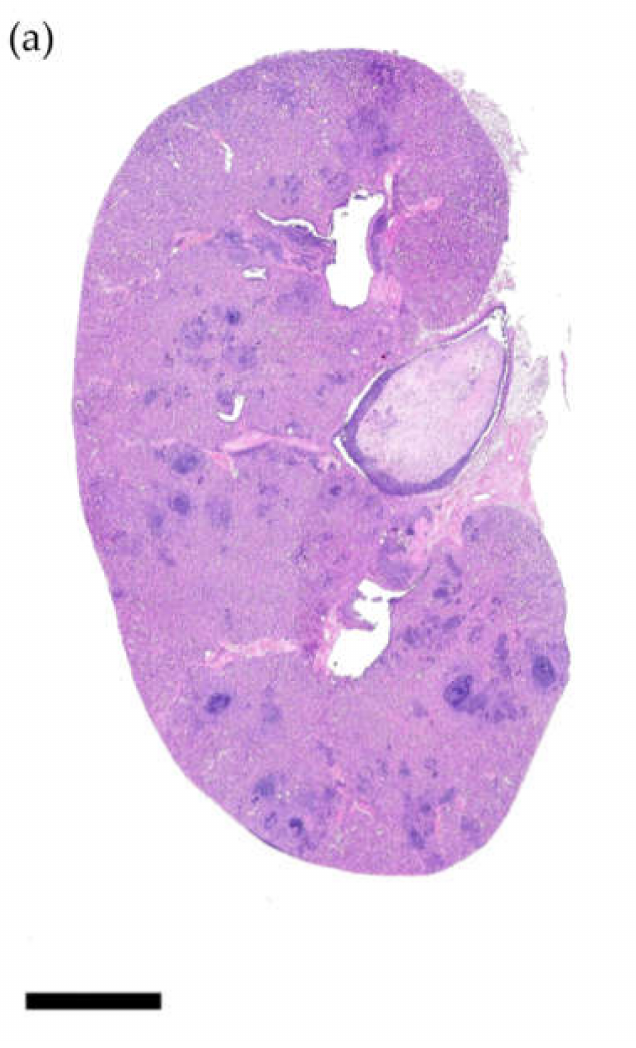
Figure 2. Histological section of the kidney of a mouse belonging to the Cal35-infected CP-implant group that died of candidemia ( a ) and histological sections at higher magnifications in haematoxylin and eosin staining ( b ) and Groccot’s stain ( c , d ). Black, blue, and red bars represent 2 mm, 50 µ m, and 20 µ m,